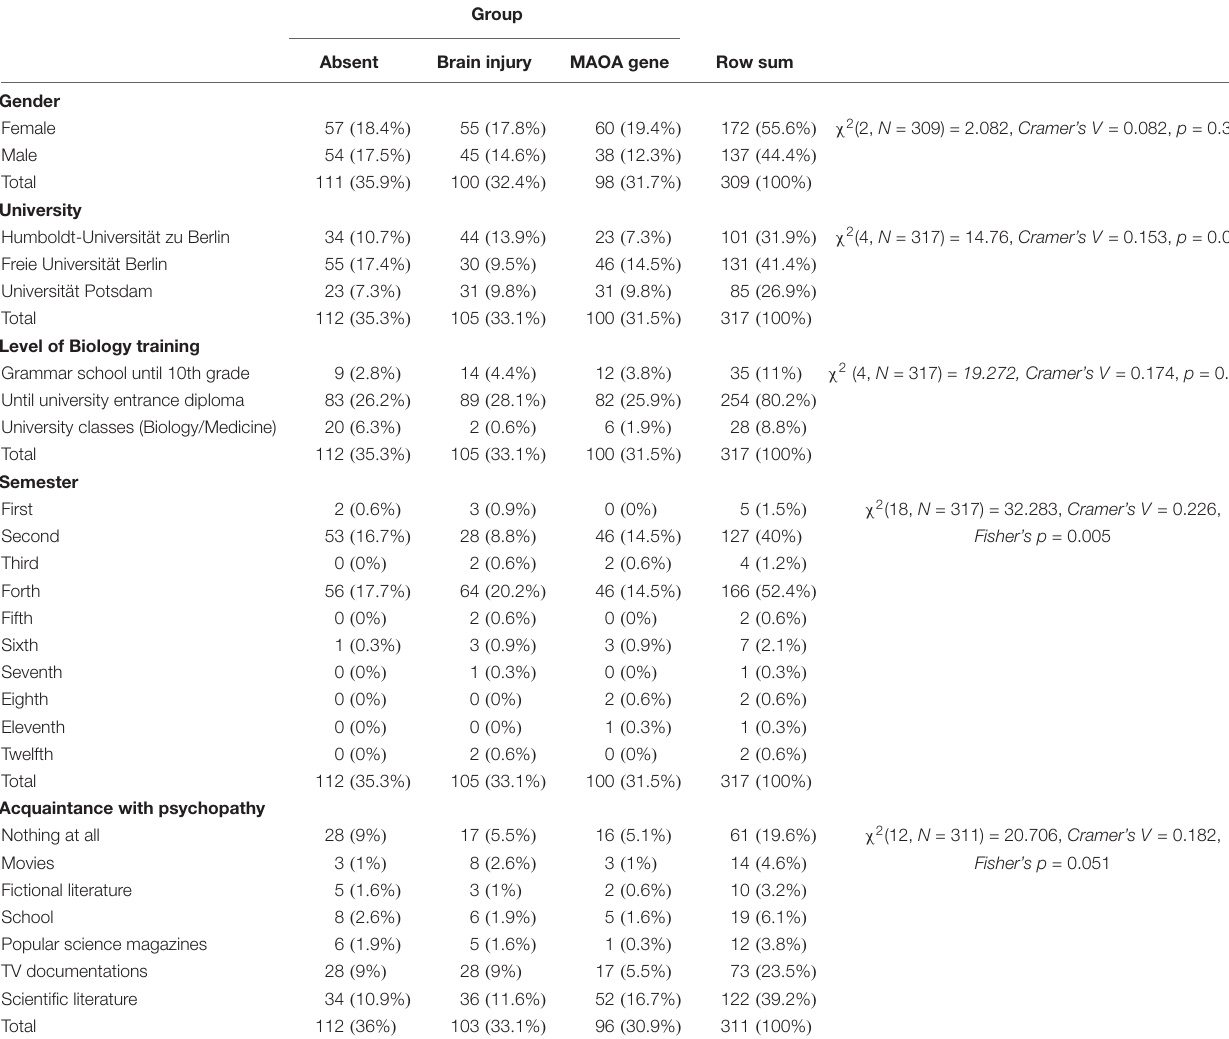
TABLE 1 | Comparison of baseline characteristics between the groups. Group Absent Brain injury MAOA gene Row